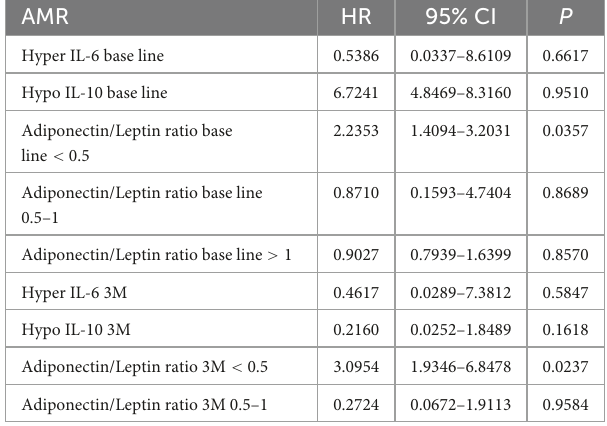
TABLE 7 Cox proportional hazard model, end point: antibody-mediated rejection in protocol graft biopsy.